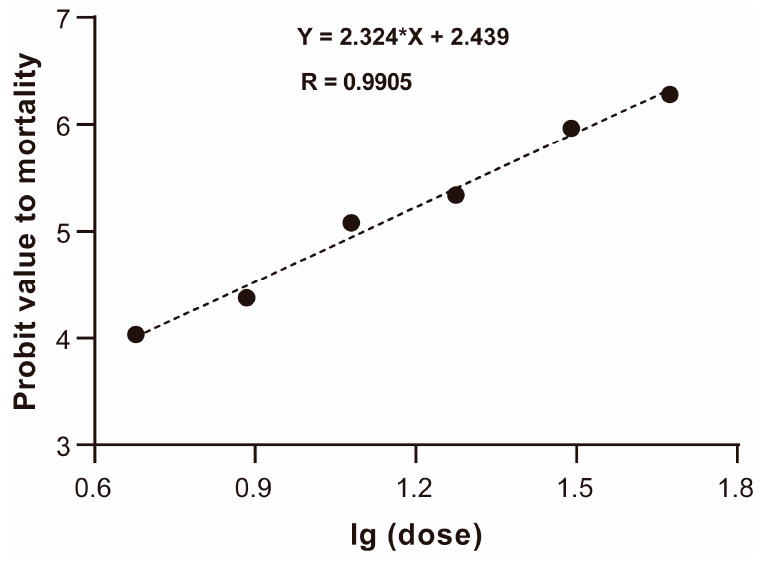
Figure 1. Toxicity regression curve of ternary mixed fungicide of ABP (azoxystrobin: boscalid: pyraclostrobin = 1:1:1, m/m/m) on Apis cerana by acute oral toxicity test.